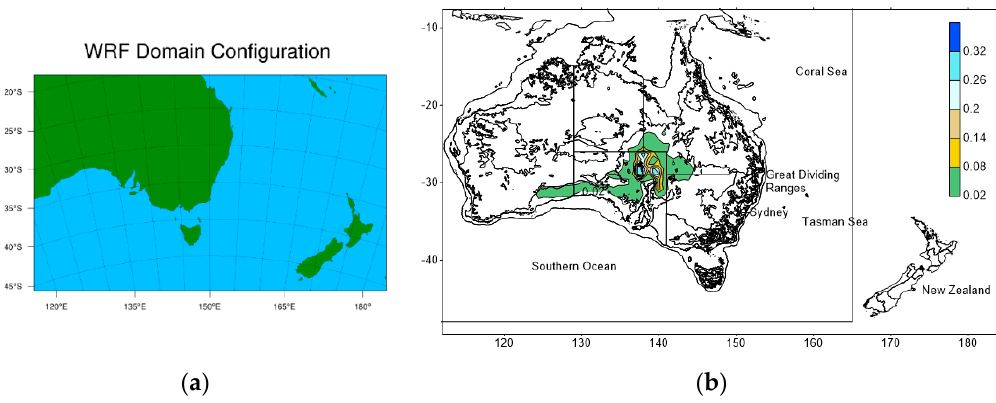
Figure 2. ( a ) Modelling domain (Lambert projection) with 15 km × 15 km resolution (lat from − 45.5384° to − 17.914°, and longitude from 116.025° to 184.175°). ( b ) The topographic sand erodibility (0–1) contour map (coloured) within the topography of the Australian continent is used by the WRF-Chem dust module to scale the dust flux.